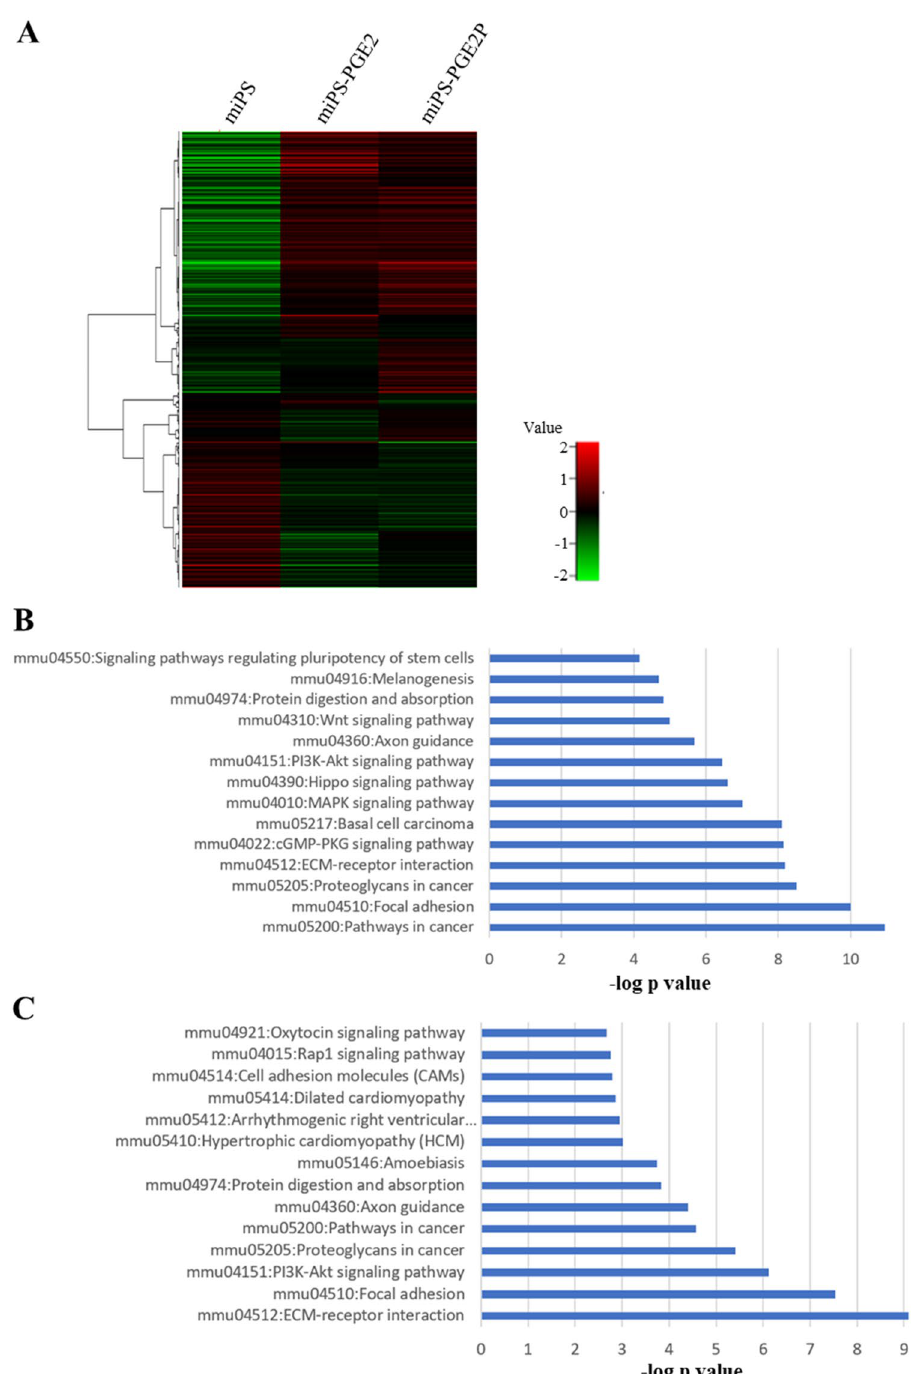
Figure 6. Transcriptome analysis of miPS-PGE2 and miPS-PGE2P cells. ( A ) A heatmap of gene expression profiles between miPSCs, miPS-PGE2 and miPS-PGE2P cells. ( B , C ) The results of KEGG pathway analysis showing the top enriched pathways compared to miPSCs. ( B ) miPS-PGE2 cells. ( C ) miPS-PGE2P